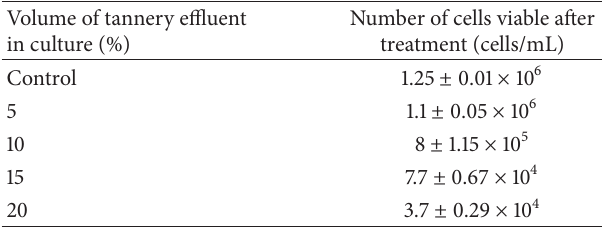
Table 6: Effect of tannery effluent on leukocytecell